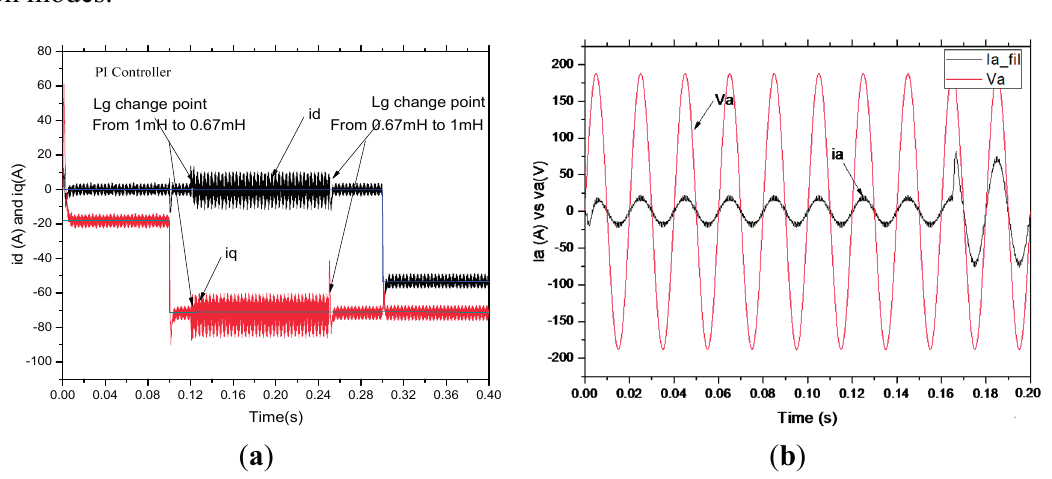
Figure 6. ( a ) Waveforms of the active and reactive current components when the DC micro-grid is interfacing with the AC micro-grid. ( b ) Waveforms of the phase voltage and current at the point of common